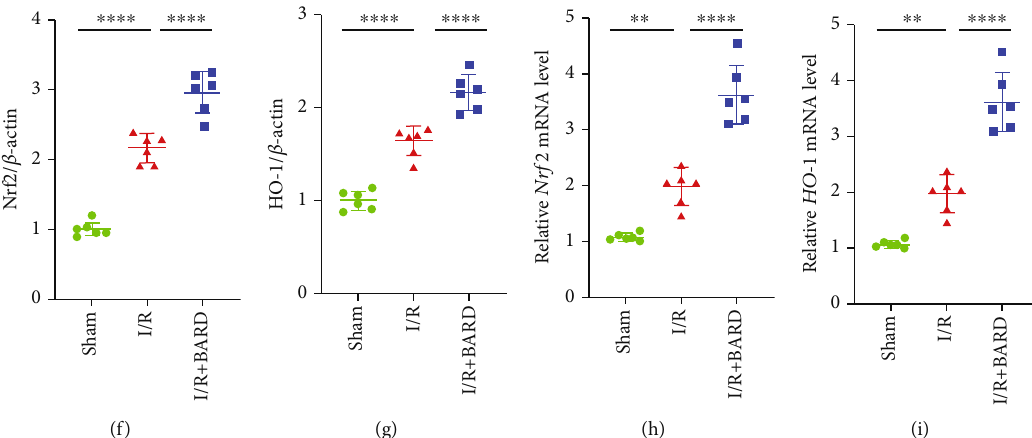
Figure 5: BARD activates the Nrf2/HO-1 pathway to alleviate myocardial I/R injury. (a) Nrf2 immunohistochemistry staining. (b) HO-1 immunohistochemical staining. (c) The positive cell amounts of Nrf2. (d) The amounts of HO-1-positive cells. (e) Western blot of Nrf2 and HO-1. (f, g) Nrf2 and HO-1 expression levels were determined by western blotting. (h, i) Nrf2 and HO-1 mRNA expression levels were measured by real-time PCR analysis. Magni fi cation of microscope: × 200 and × 400. Scale bar: 50 μ m and 100 μ m. ∗∗ P < 0 : 01 and ∗∗∗∗ P < 0 : 0001